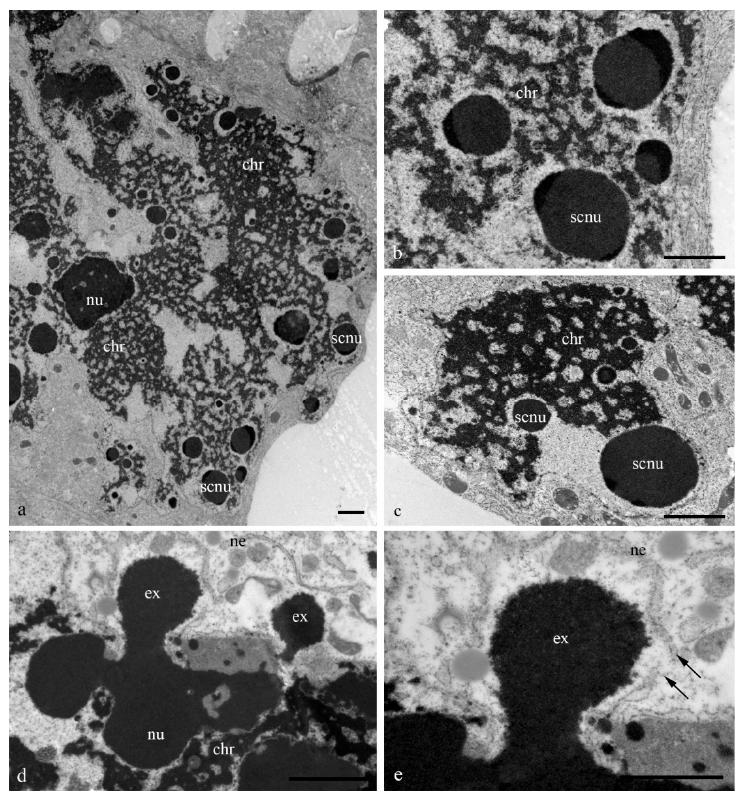
Figure 5. Ultrastructure of the wheat embryo sac nuclei at the middle and late stages of programmed cell death. Segregated nucleolus components in the lacunae of polytene chromosomes (chr) of antipodal nuclei ( a – c ) and nucleolus extrusion (ex) through nuclear envelope breaks ( d , e ; arrows). nu—nucleolus; scnu—segregated nucleolus components, ne—nuclear envelope. The scale is 2 µm. Numerous lipid droplets were detected in the cytoplasm of antipodal cells at the early and middle stages of differentiation near the cisterns of the granular endoplasmic reticulum and mitochondria (Figure 6a–d). During the late stages of death, lipid droplets were observed in the nucleus (Figure 6e,f).